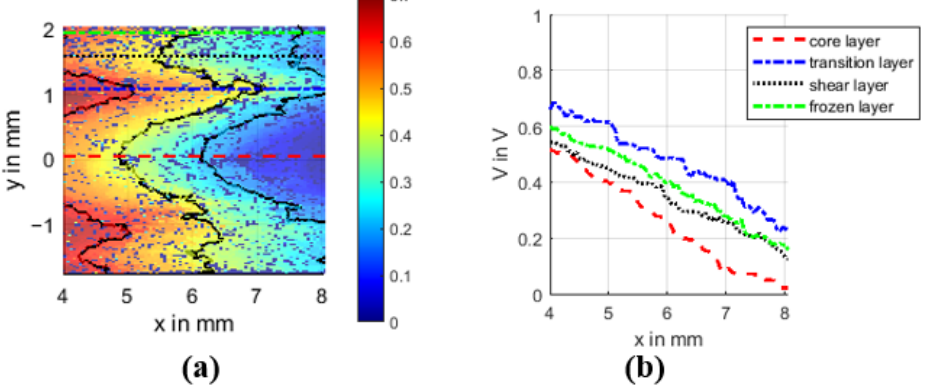
Figure 14. Potential field section of the near gate area ( a ), with marked positions of the potential profiles in ( b ) along these